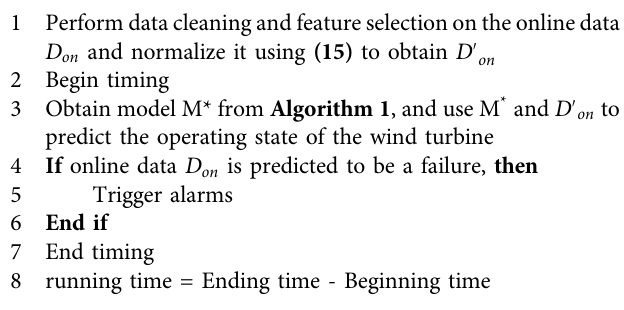
Algorithm 3 Online implementation of CS-ERT fault detection method.